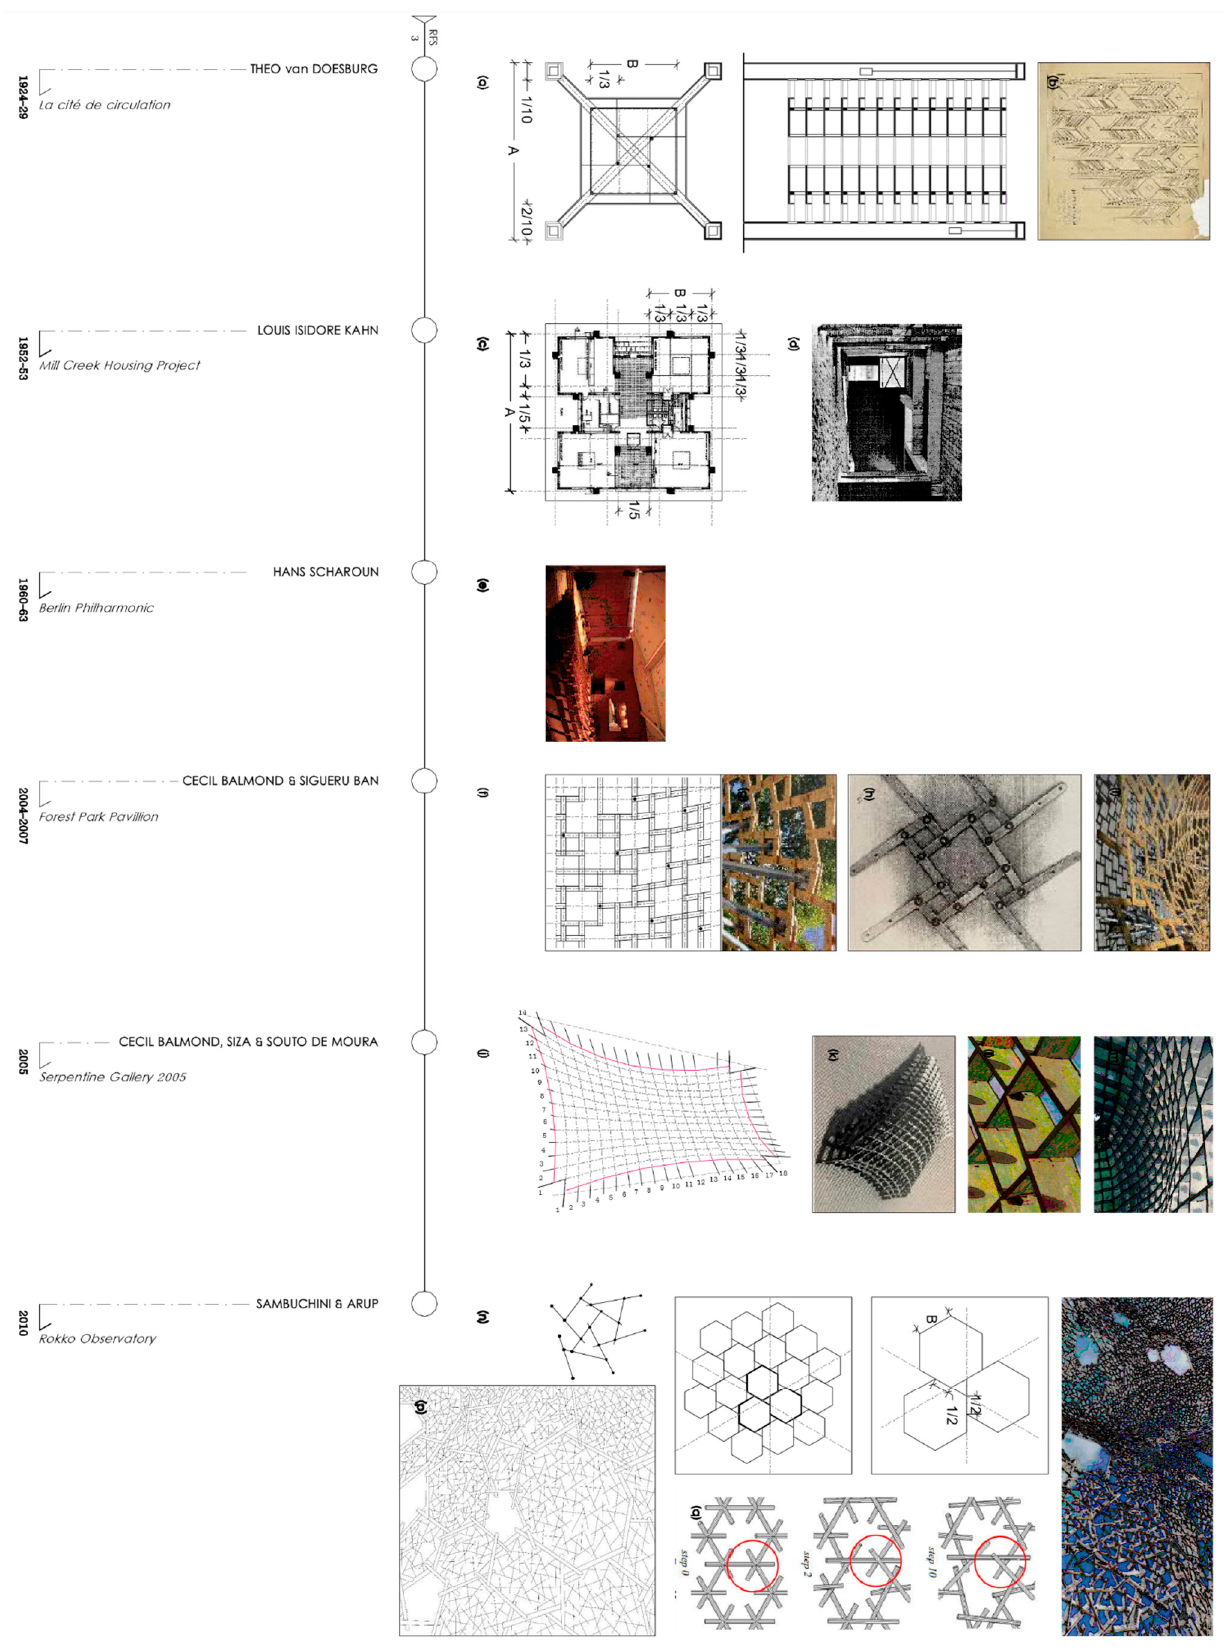
Figure 5. Chronological diagram of reciprocal frame structure 3.